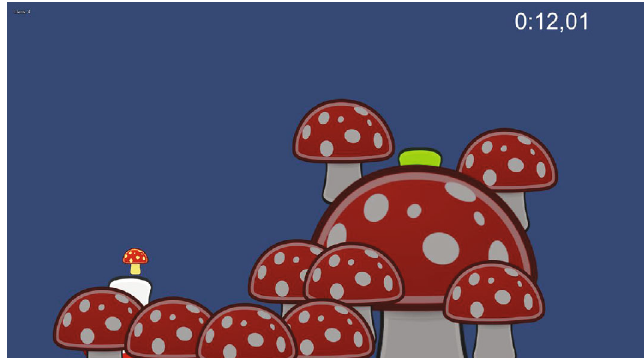
Figure 8: Screenshot of a fl ying mushroom computer